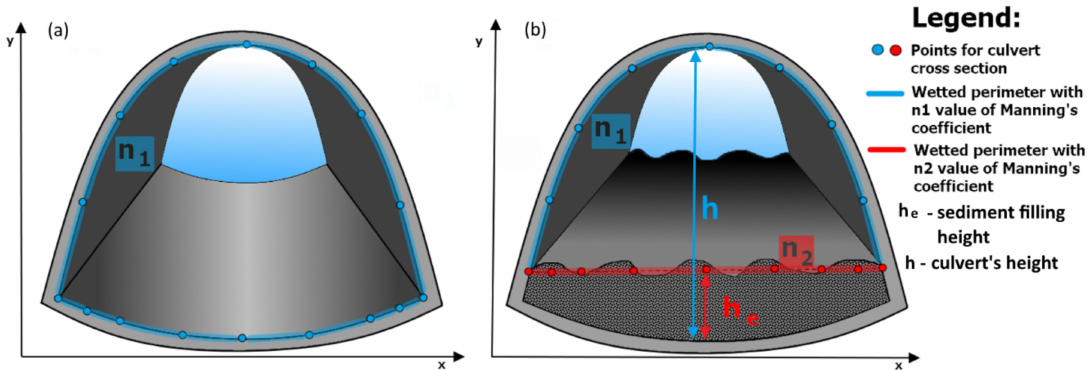
Figure 5. Defining the points and friction coefficients for the cross-section profile of the culvert: ( a ) for the designed culverts and ( b ) existing culverts filled with sediments.